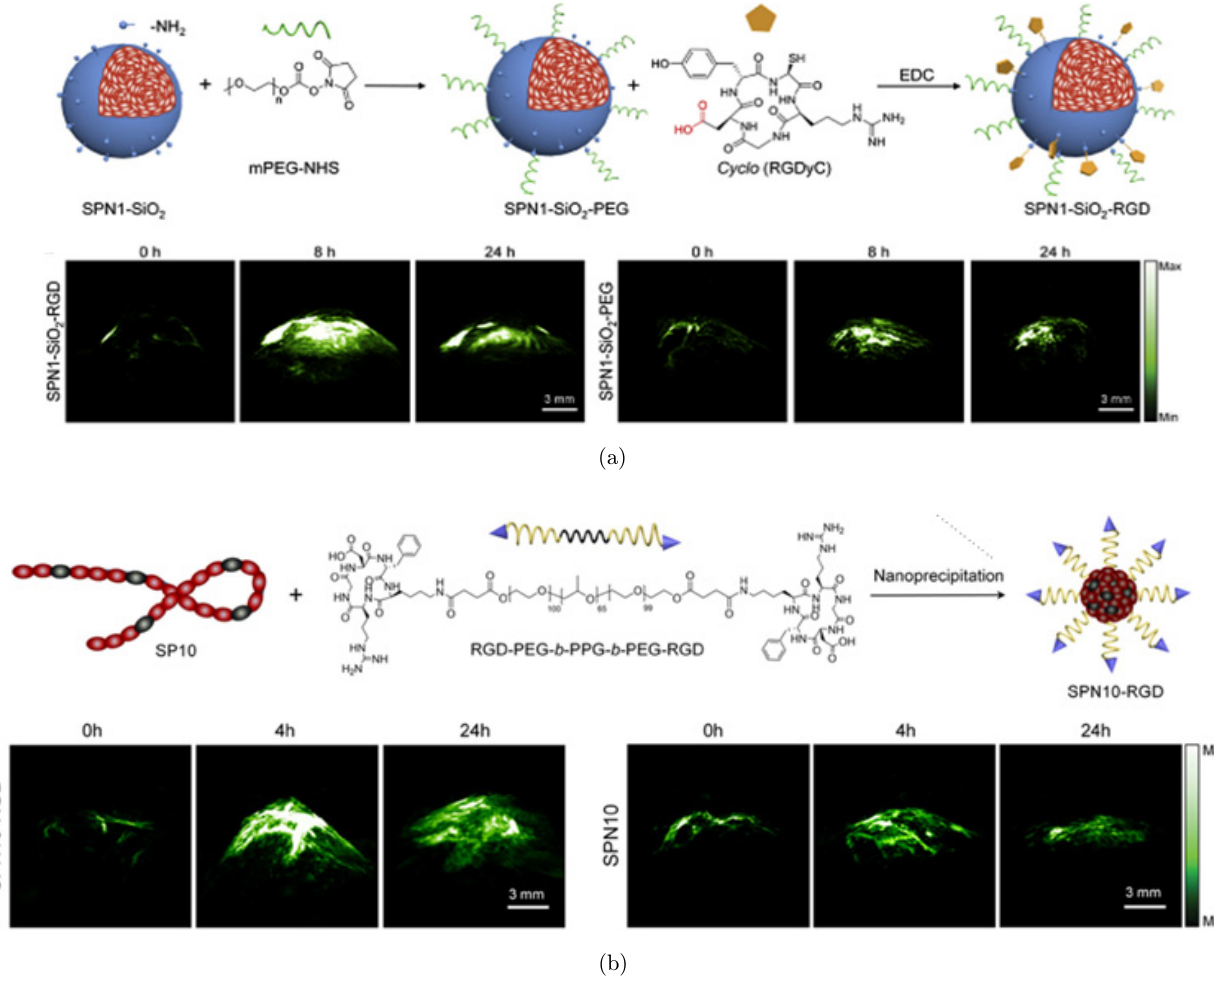
Fig. 3. (a) PA images of tumor at 0, 8 and 24 h post-injection of CPNs-SiO 2 . a (b) PA images of tumor after injection of CPN10-RGD or SPN10.